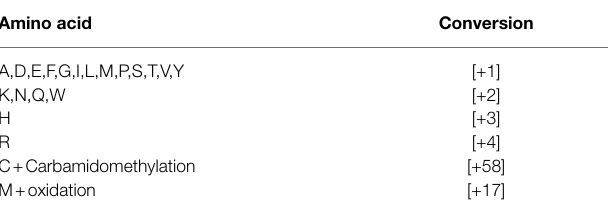
TABLE 2 | Light 14 N to heavy 15 N amino acid conversion for 20 amino acids. Amino acid Conversion